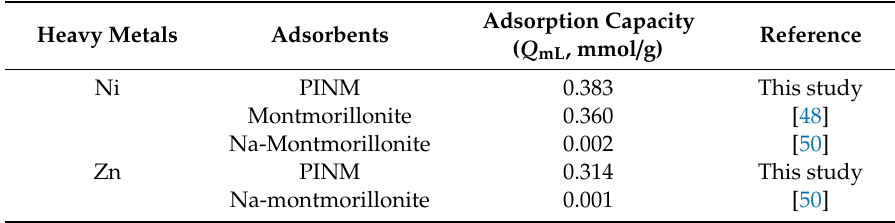
Table 4. Adsorption capacity of Ni and Zn by various